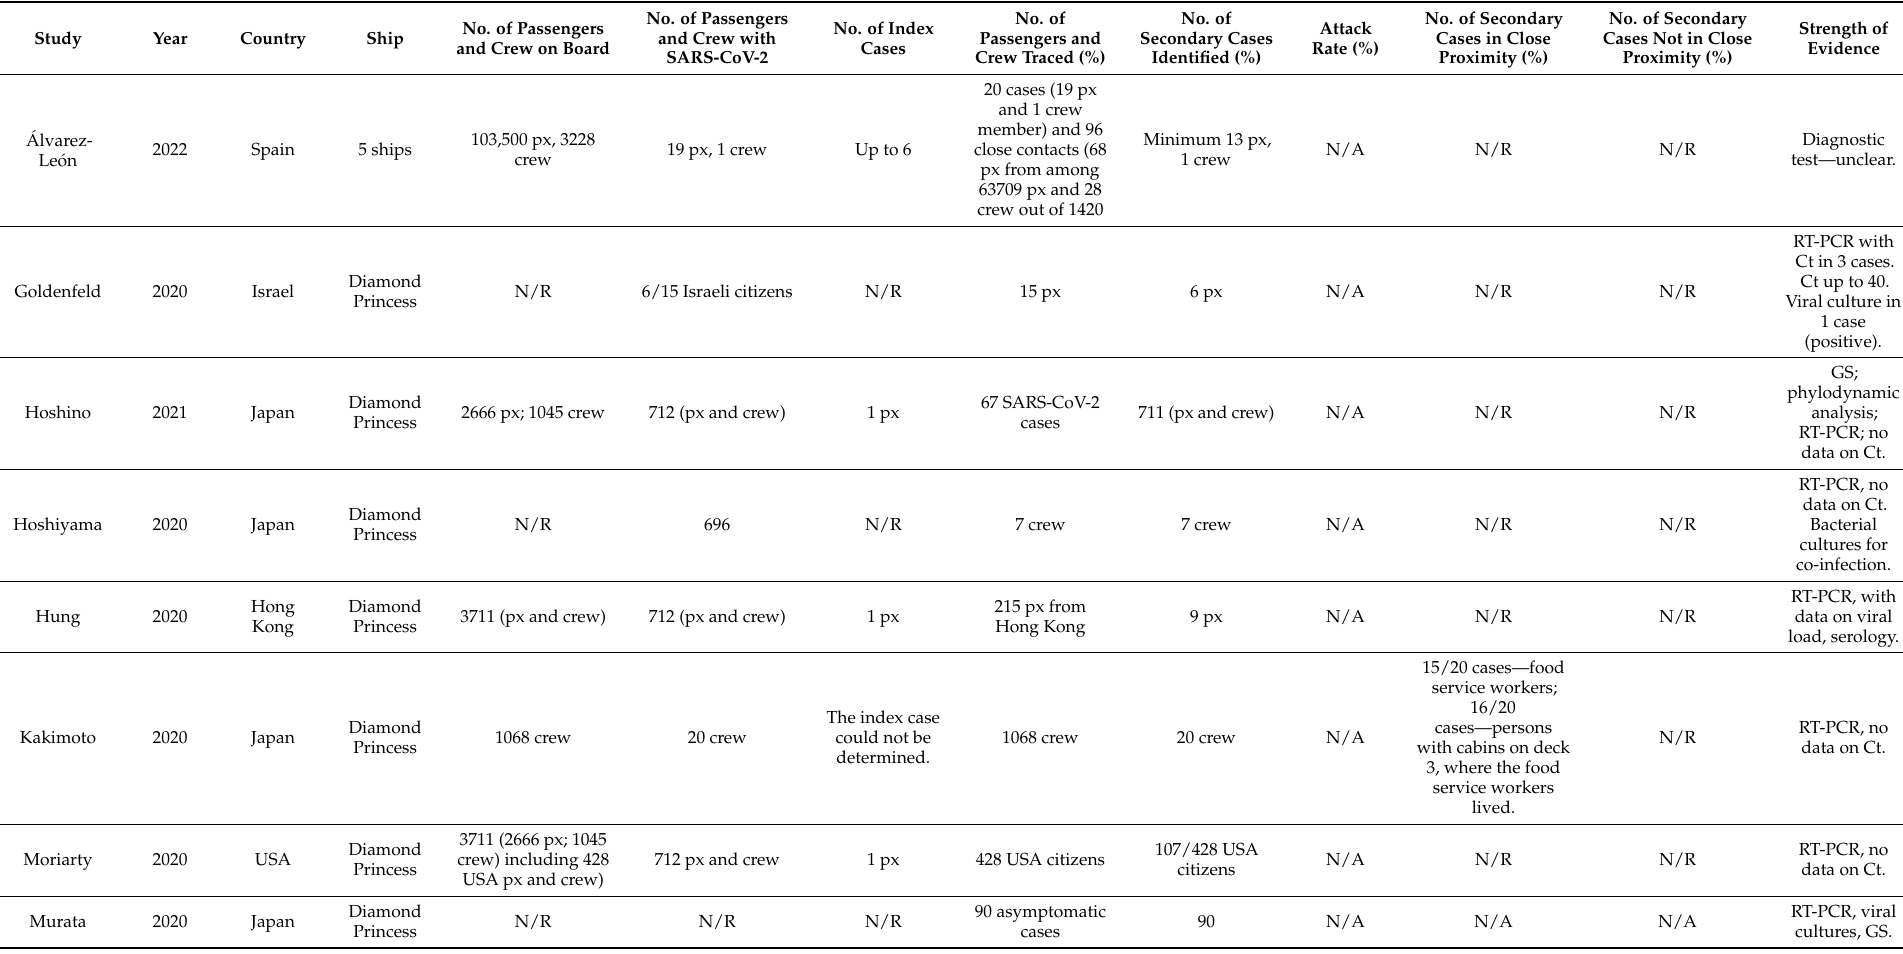
Table 1. Onboard transmission